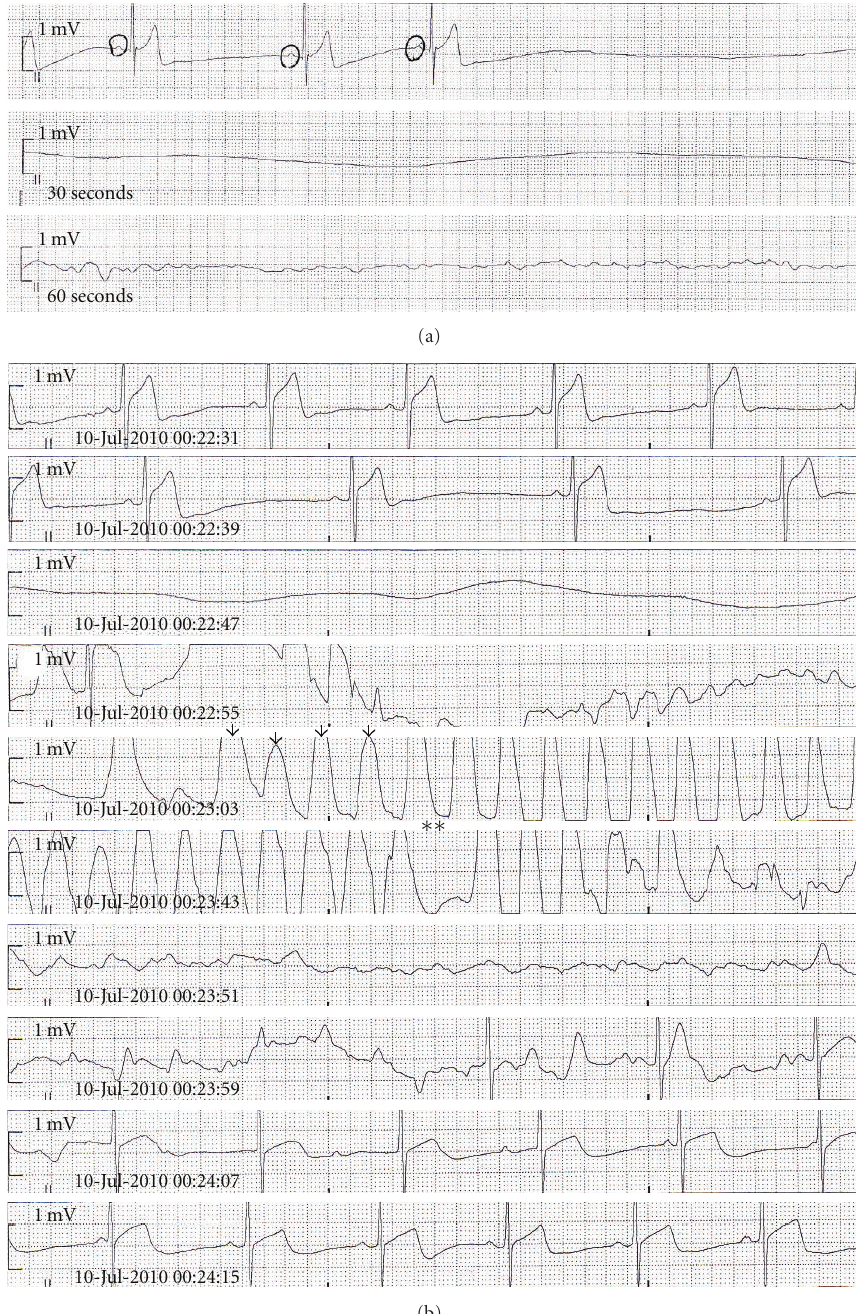
Figure 1: (a) Sinus bradycardia progressing to sinus arrest and asystole. (b) Recurrent sinus arrest, asystole, chest compression artifact (arrows), and eventual restoration of sinus rhythm. Asterisks ( ∗∗ ) represent approximately 30 seconds of elapsed time.